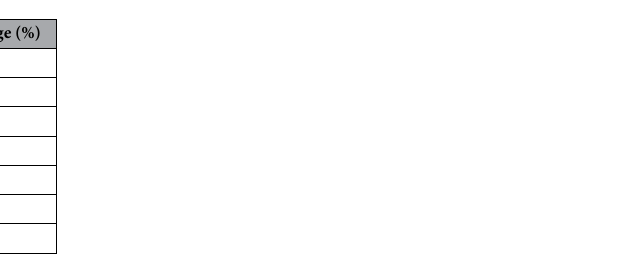
Table 3. Summary of unigene annotations.